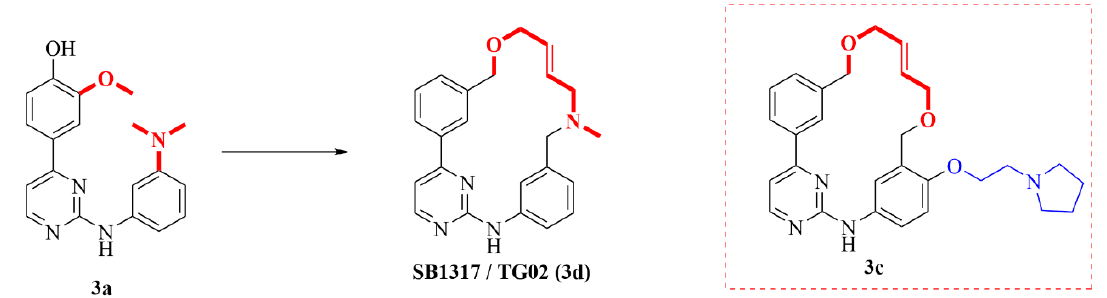
Figure 5. Structural modification of compound SB1317/TG02 ( 3d ).